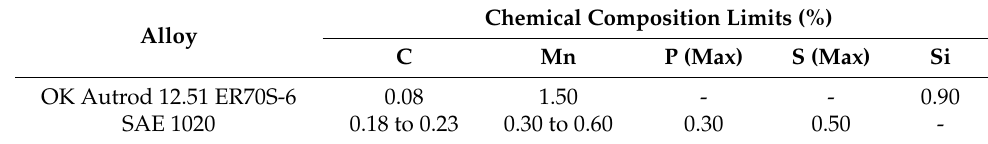
Table 1. Chemical compositions of wire and base metal [30,31].